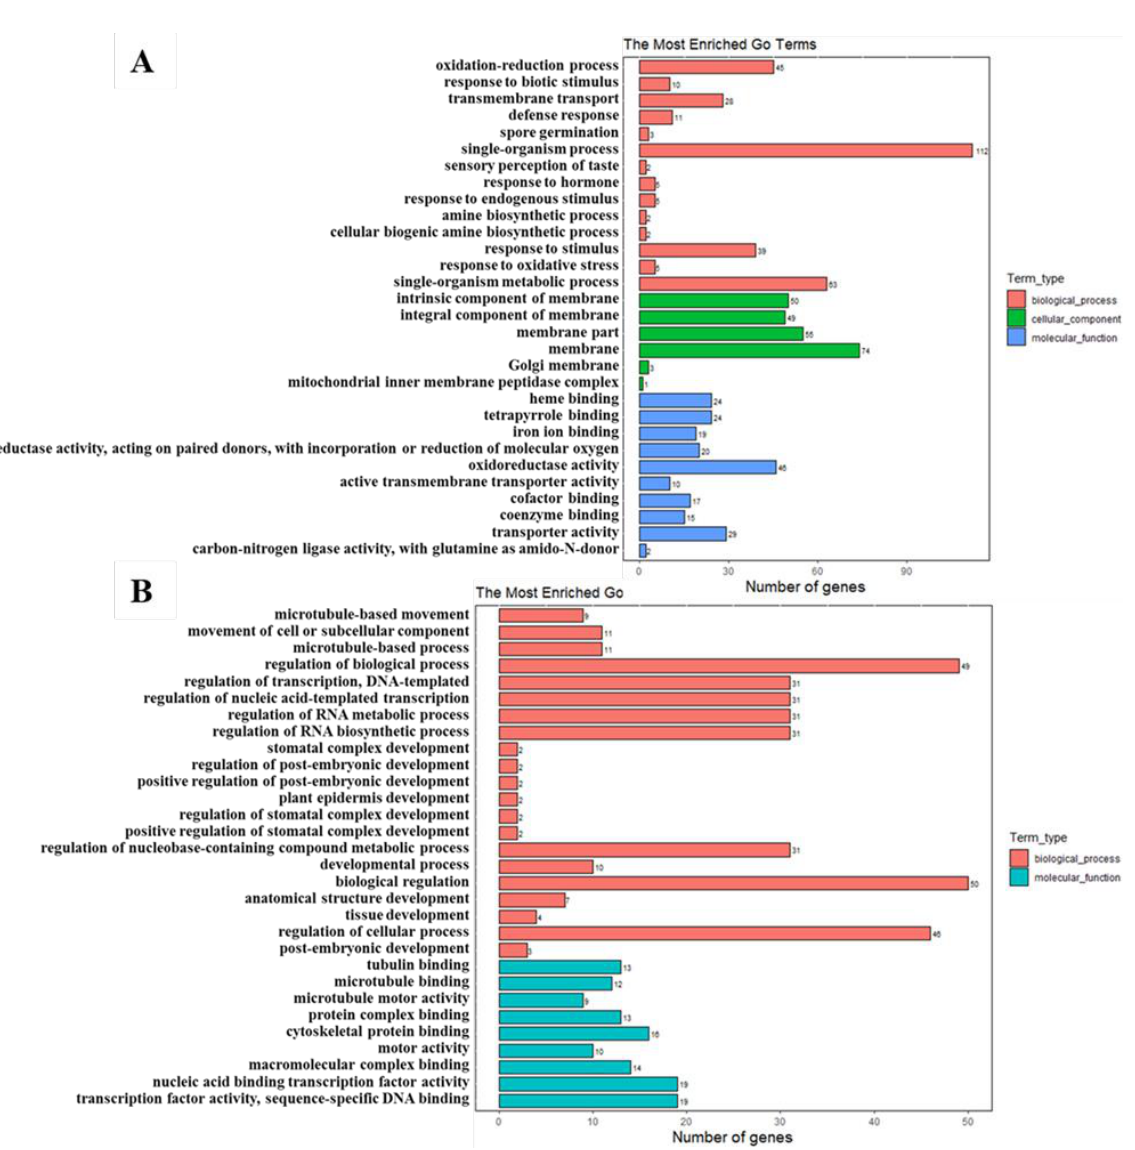
Figure 14. GO enrichment analysis of DEGs. ( A ) GO enrichment analysis of significantly up-regulated genes. ( B ) GO enrichment analysis of significantly down-regulated genes.